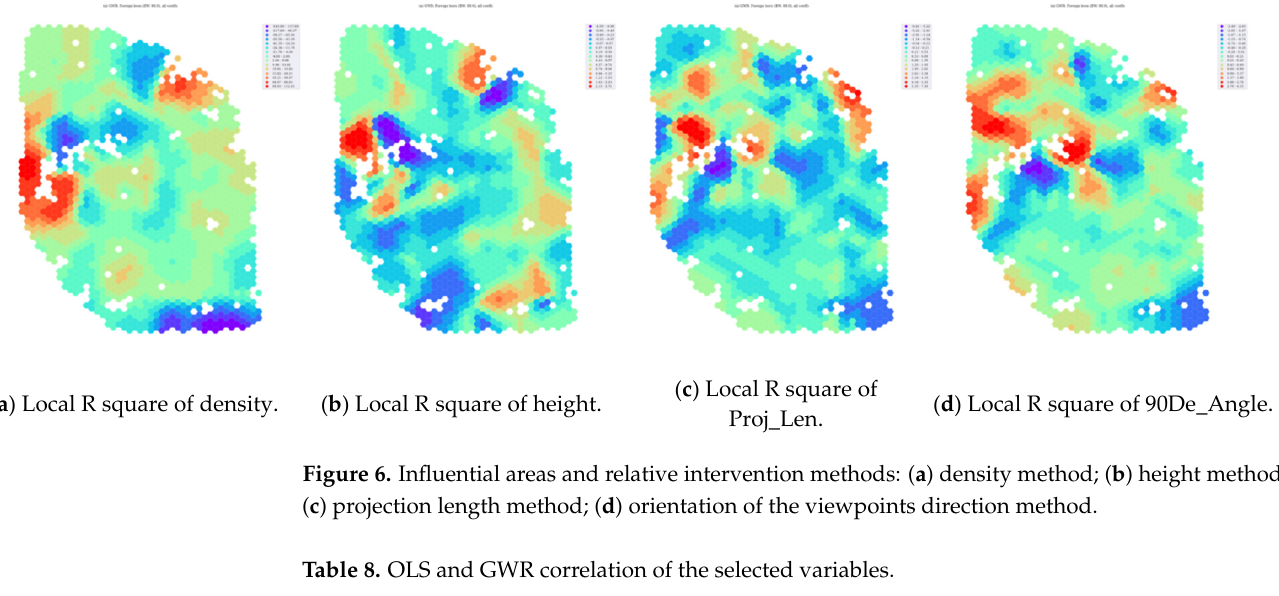
Table 8. OLS and GWR correlation of the selected variables.